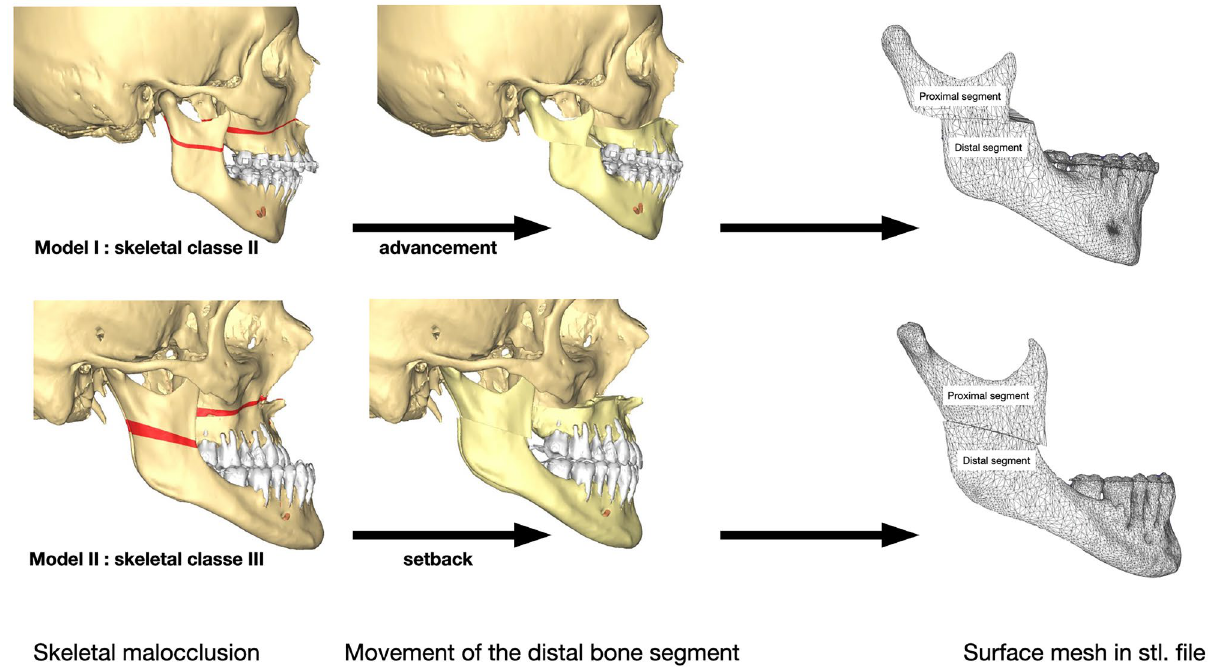
Figure 2. Three-dimensional T1 and T2 models obtained respectively from Class II and III skeletal malocclusion during 3D planning.